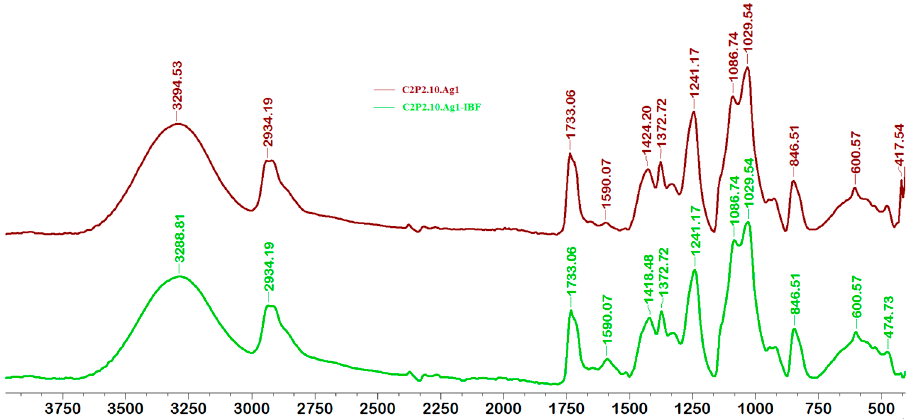
Figure 3. FT-IR spectra for films type C2P2.